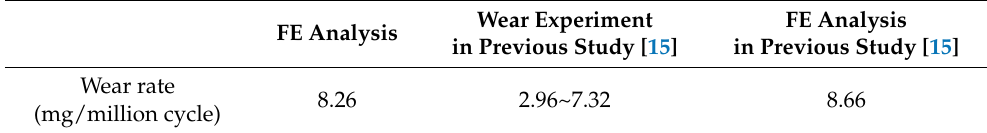
Table 2. Comparison of wear rate of FE analysis and actual